Question: Compose a caption that would accompany this figure in a paper.
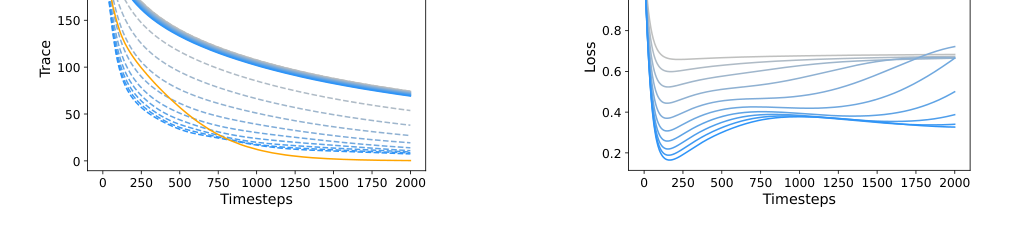
Answer: We train linear models on our toy model using 1-SAM. Bluer curves denote larger ρ. We randomly initialize the model, although we observe similar curves when initialized at the origin.